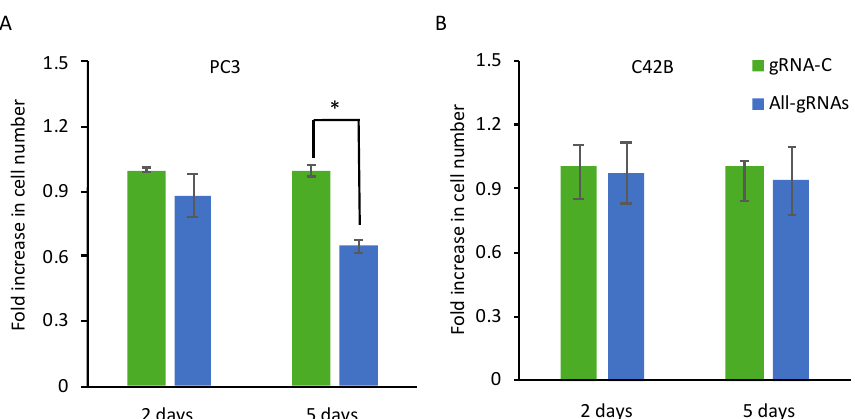
Figure 4. CRISPR-mediated induction of Dkk-3 reduces PC3 but not C4-2B cell number. ( A , B ) Crystal violet assays for PC3 ( A ) and C4-2B ( B ) cells transfected with dCas9-VPR and control (gRNA-C) or DKK3 (All-gRNAs) gRNAs after two or five days. Values shown represent the average fold change, relative to gRNA-C cells at each time point, ± SD of triplicate wells ( n = 3). * p < 0.05, two-tailed Student’s t -test.